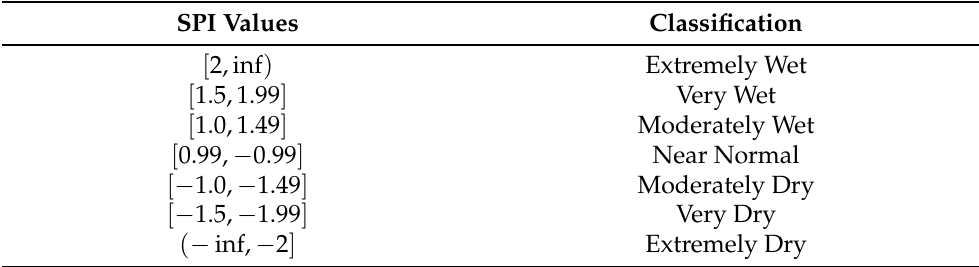
Table A1. SPI ranges for different meteorological